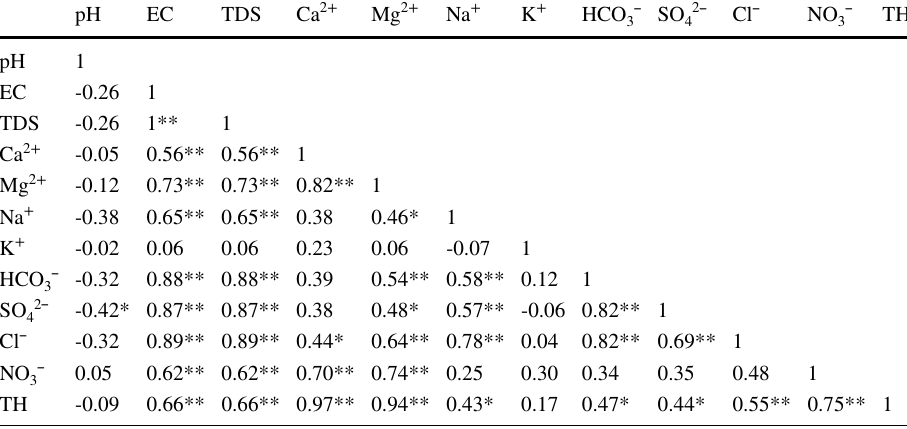
*, **Correlation is significant at the 0.05 and 0.001 level